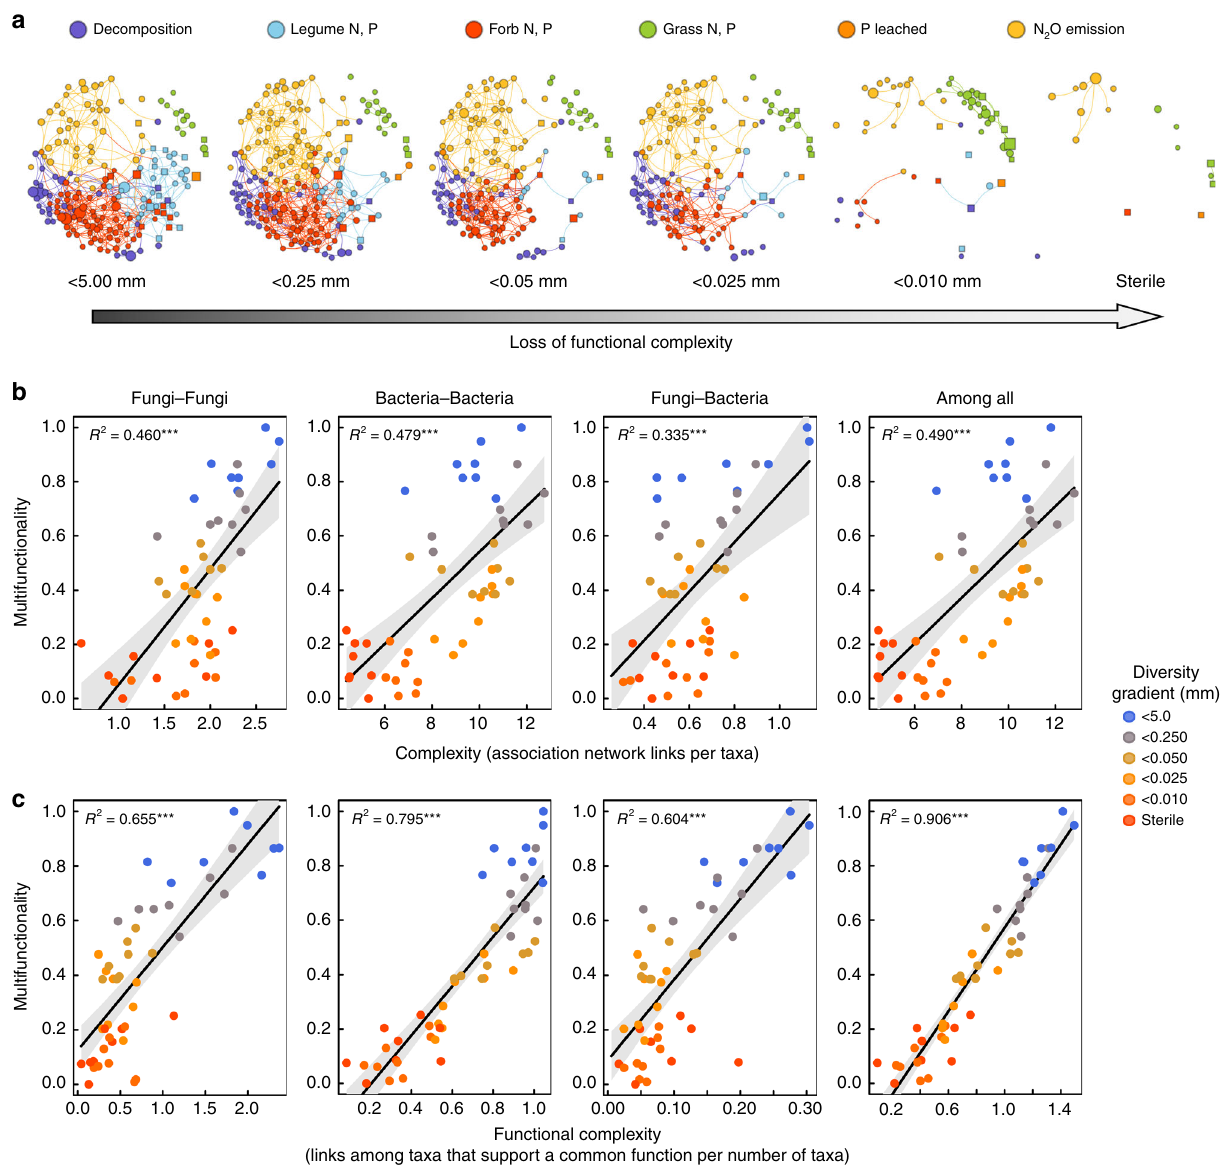
Fig. 3 Relationship between microbial association network complexity and multifunctionality. a Illustrates OTUs that were detected to predict a common ecosystem function (i.e. taxa with coef fi cients that are related to increased plant nutrient uptake and decomposition or reduce nutrient loss). Nodes (OTUs) and links are colored by the functions with which they are most strongly associated (Note: ‘ functional complexity ’ is de fi ned as the ratio of the total number of links). Node size indicates the OTU was relatively more abundant within that particular treatment. For visual clarity, only OTUs that were detected to be present in 75% of all replicates of each treatment level are illustrated. Shown in ( b ) are the relationships between multifunctionality and the overall association network complexity (shown in Fig. 1b) among fungi – fungi, bacteria – bacteria, fung – bacteria and among all fungi and bacteria. The same is shown in ( c ) except only considering the links among taxa that support a function (shown in a ). Signi fi cance is indicated by * P < 0.05, ** P < 0.01, *** P < 0.001 for each linear regression. Results after detrending for richness are shown in Table